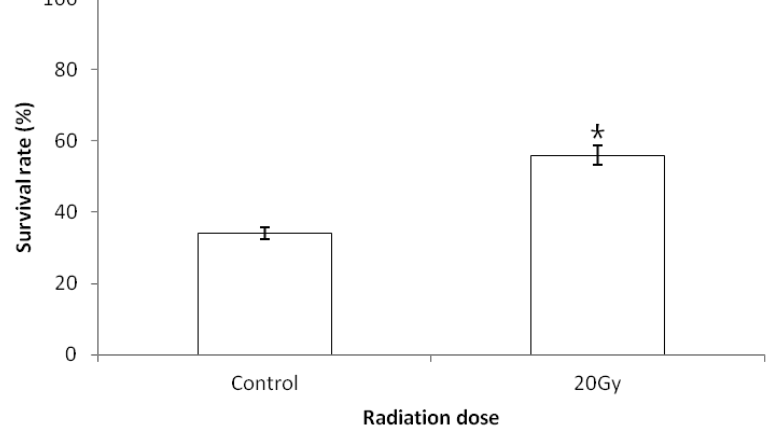
Figure 6. Effect of high water-temperature stress on abalone Haliotis diversicolor aquatilis lysozyme activity in the control or 20 Gy groups at a 0 h and 12 h incubation period.